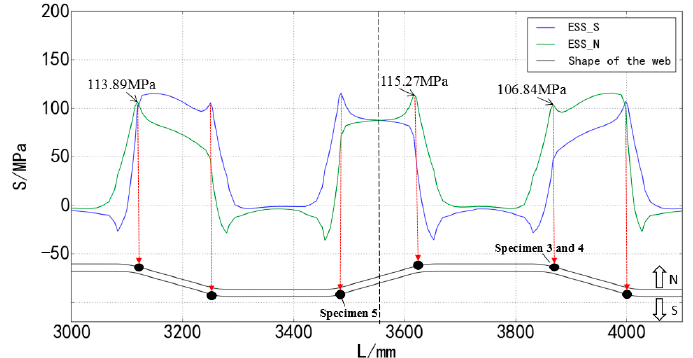
Figure 7. ESS distribution curve in the middle of the span.